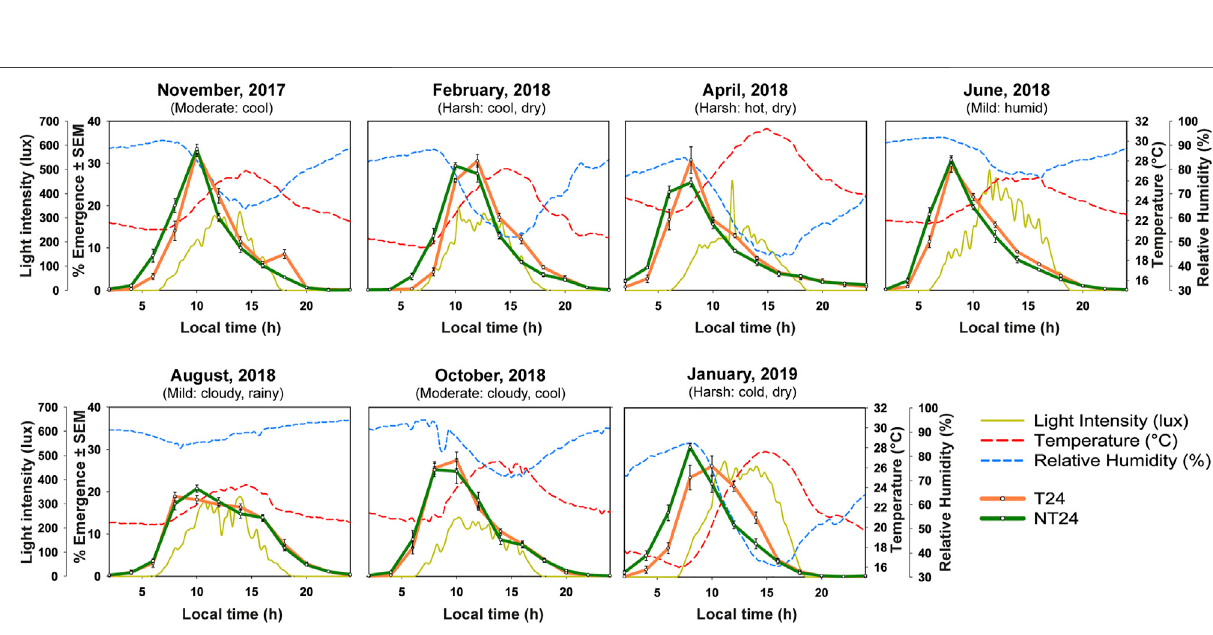
Frontiers in Physiology |